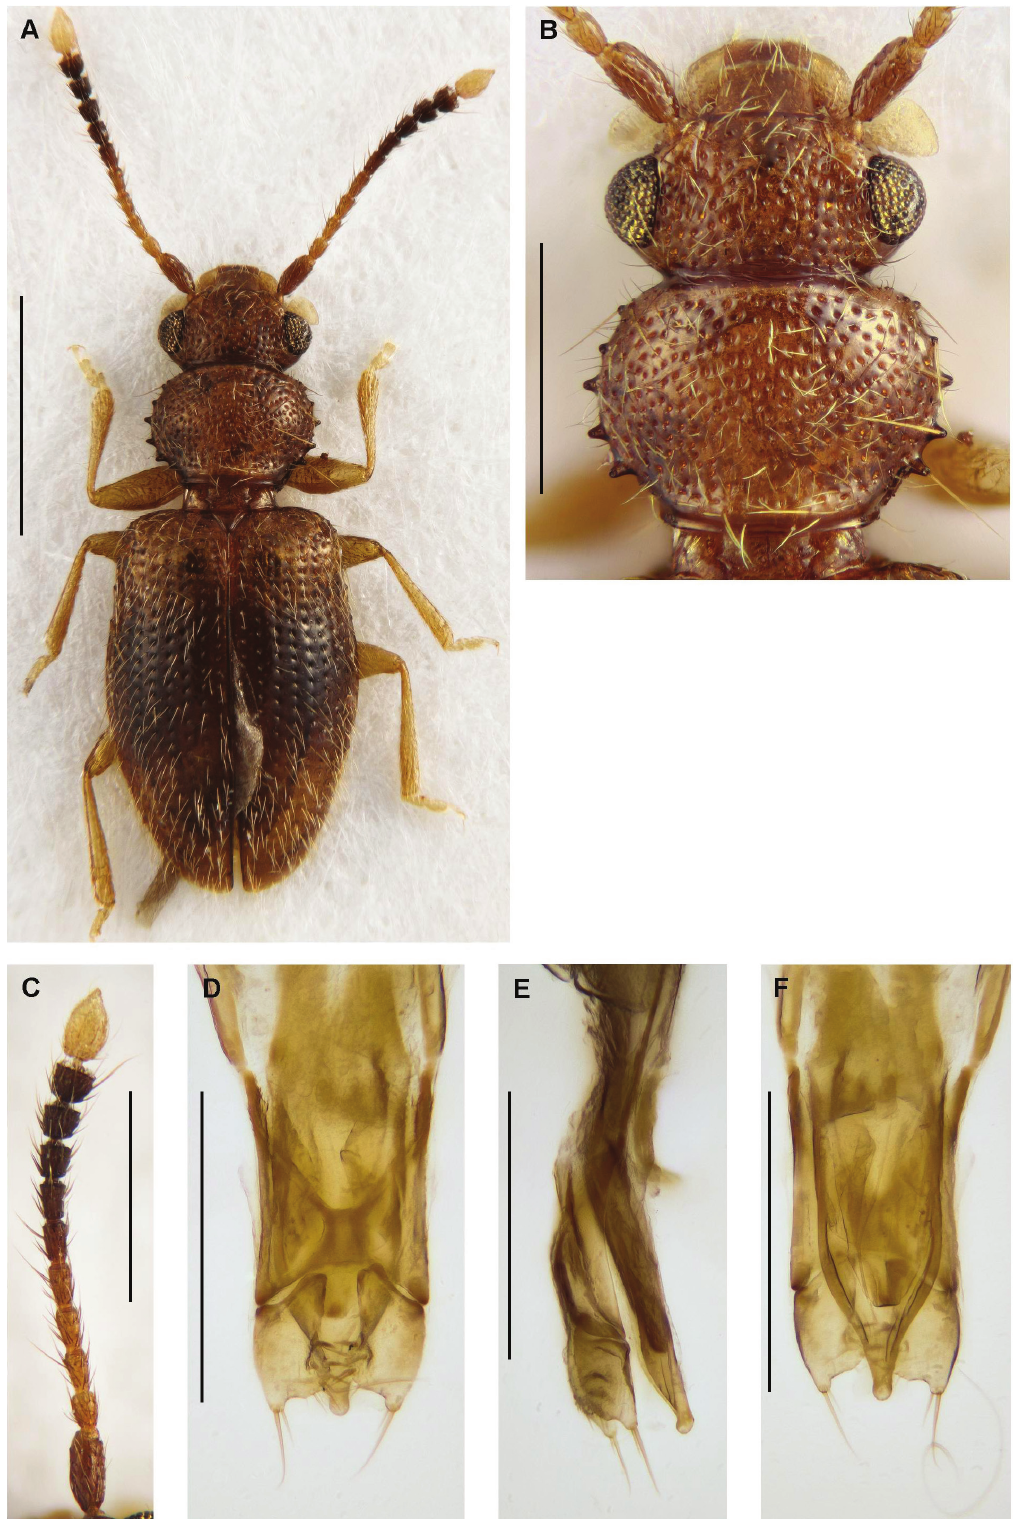
Fig. 6. Psammoecus sinuaticollis sp. nov., holotype. A . Habitus. B . Head and pronotum. C . Right antenna. D–F . Aedeagus (D = ventral, E = lateral, F = dorsal view). Scale lines: A = 1.0 mm, B–C = 0.5 mm, D–F = 0.2